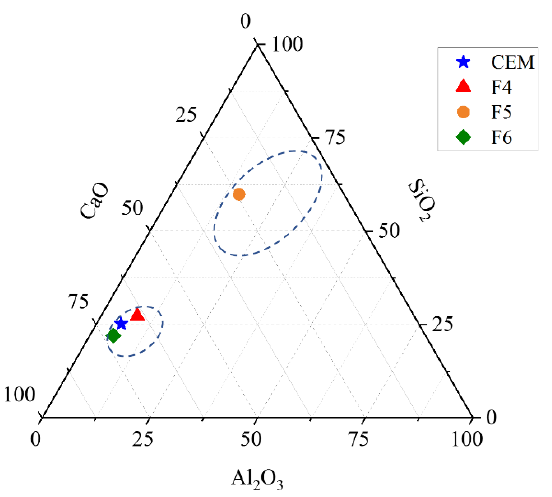
Figure 1. Ternary plot CaO-Al 2 O 3 -SiO 2 for the wood fly ash used in the experimental work. The area on the graph characteristic for Portland cement and coal fly ash is taken from [44].